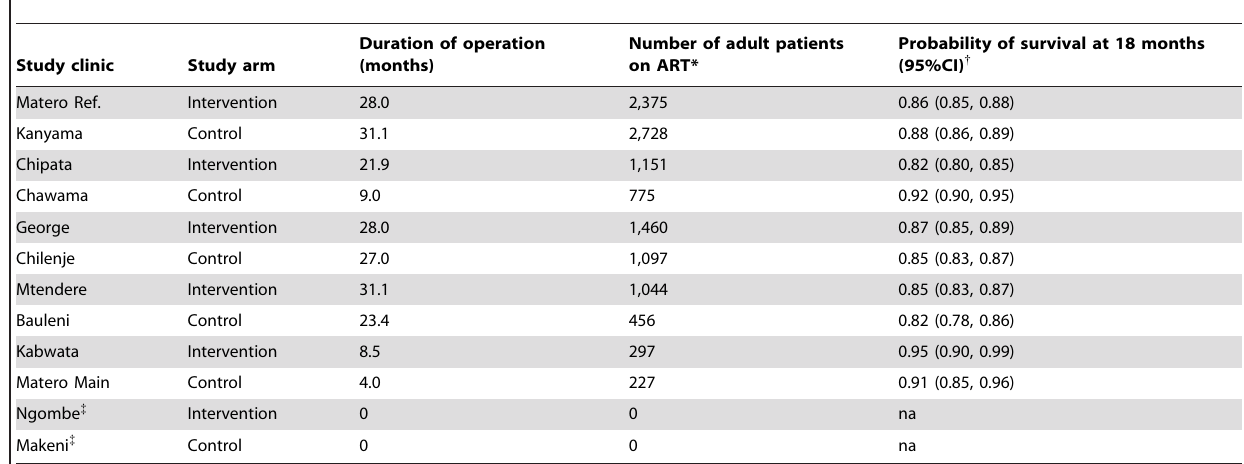
Table 1. Matched study clinic pairs (As of December 1, 2006, prior to study